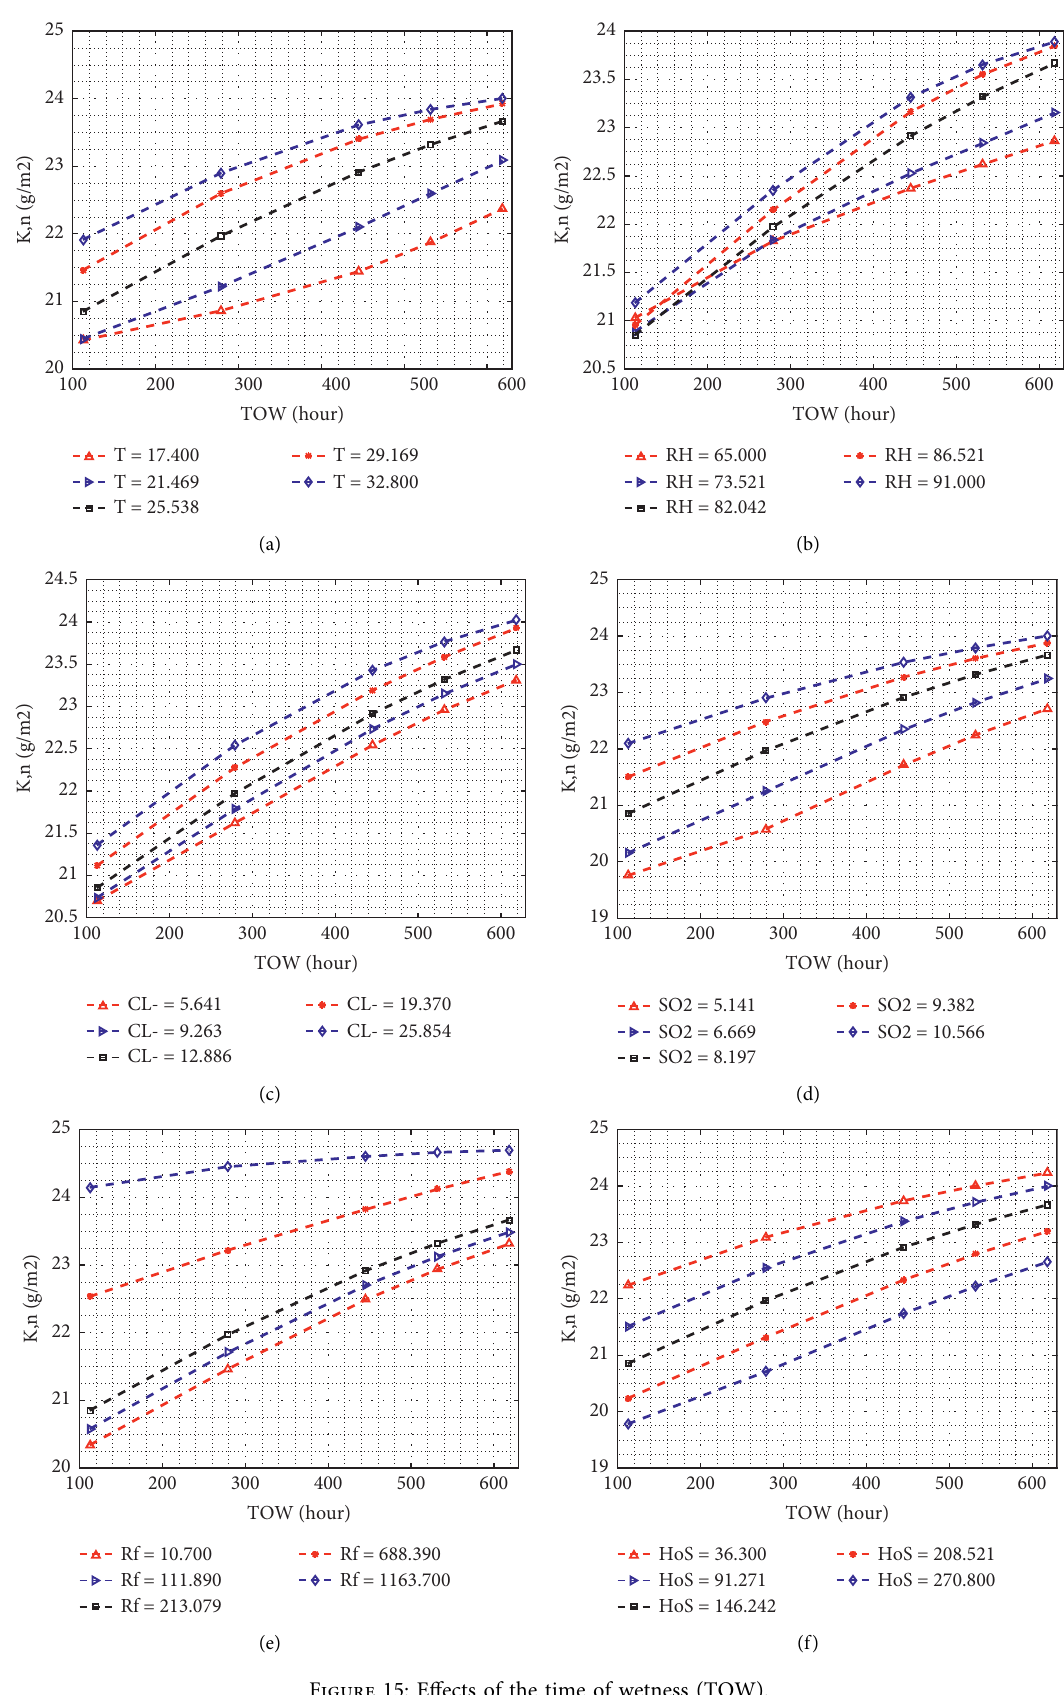
Figure 15: Effects of the time of wetness